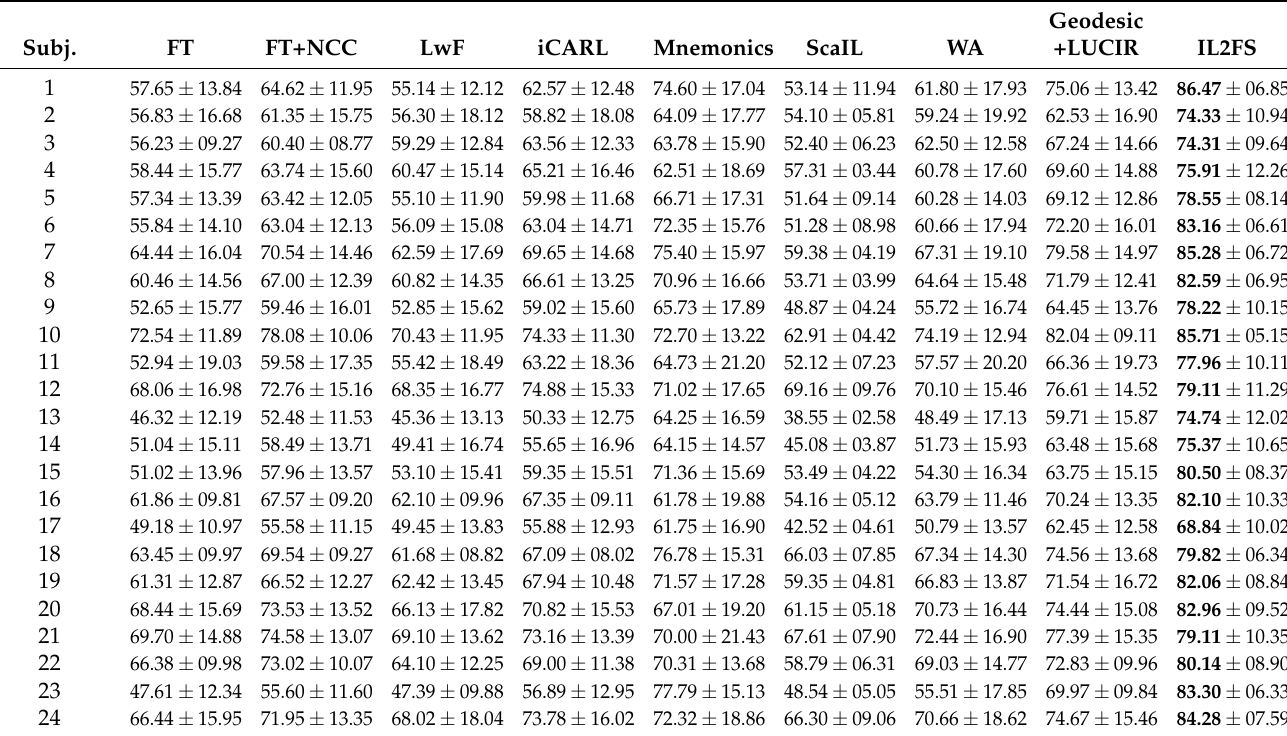
Table 4. Accuracy and standard deviation for CIL methods on the DEAP dataset using approximately 1% of the training size. The best results are in